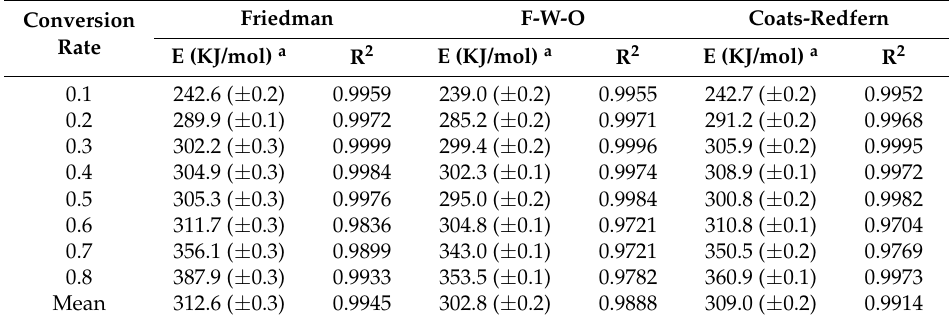
Table 3. Activation energy of the CNCs, calculated by the three methods in the range of a = 0.1 to 0.8. Conversion